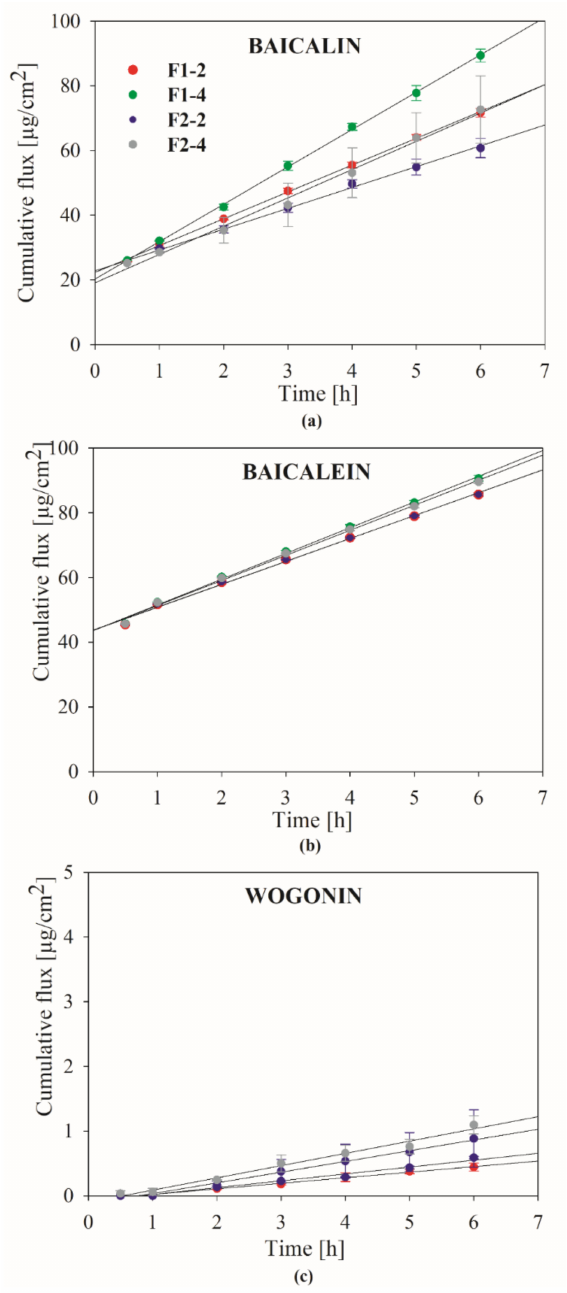
Figure 6. Dissolution profiles of ( a ) baicalin; ( b ) baicalein; ( c ) wogonin from hydrogels with binary mixture with S. baicalensis radix lyophilized extract and chitosan using acceptor solution (pH 6.6) con- taining potassium chloride, sodium chloride, di-potassium hydrogen orthophosphate, magnesium chloride, calcium chloride, and